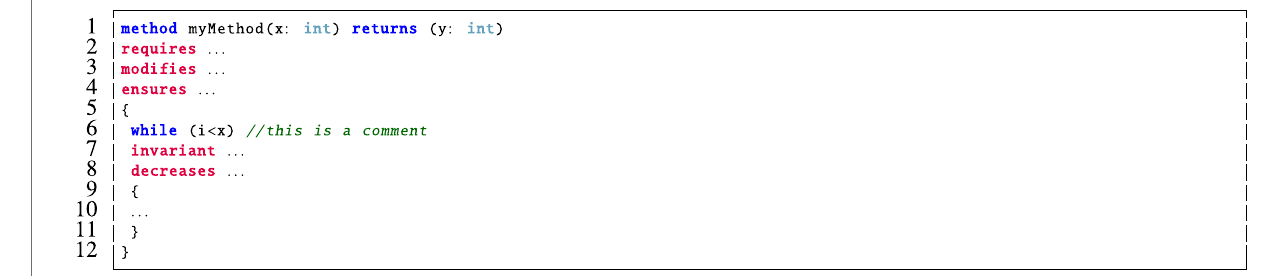
Frontiers in Robotics and AI |